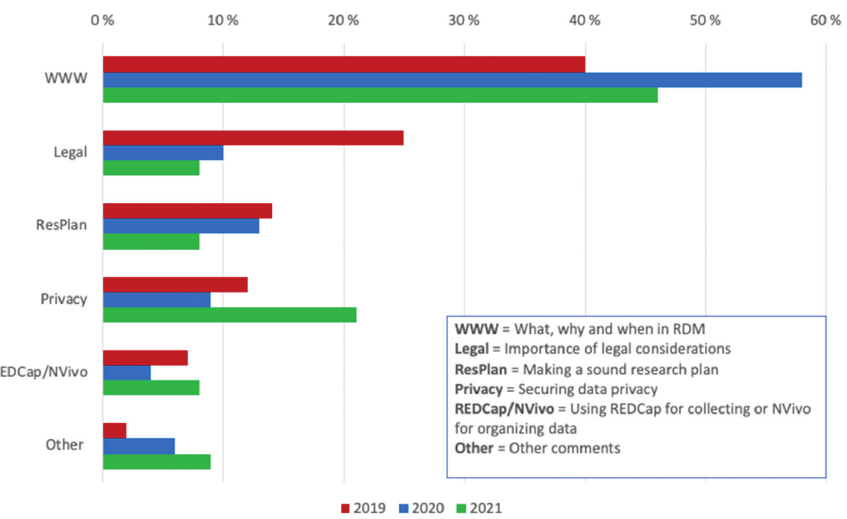
Fig. 3: Five top sub-categories based on the feedback given in the main category “What are the three things you have learned” in